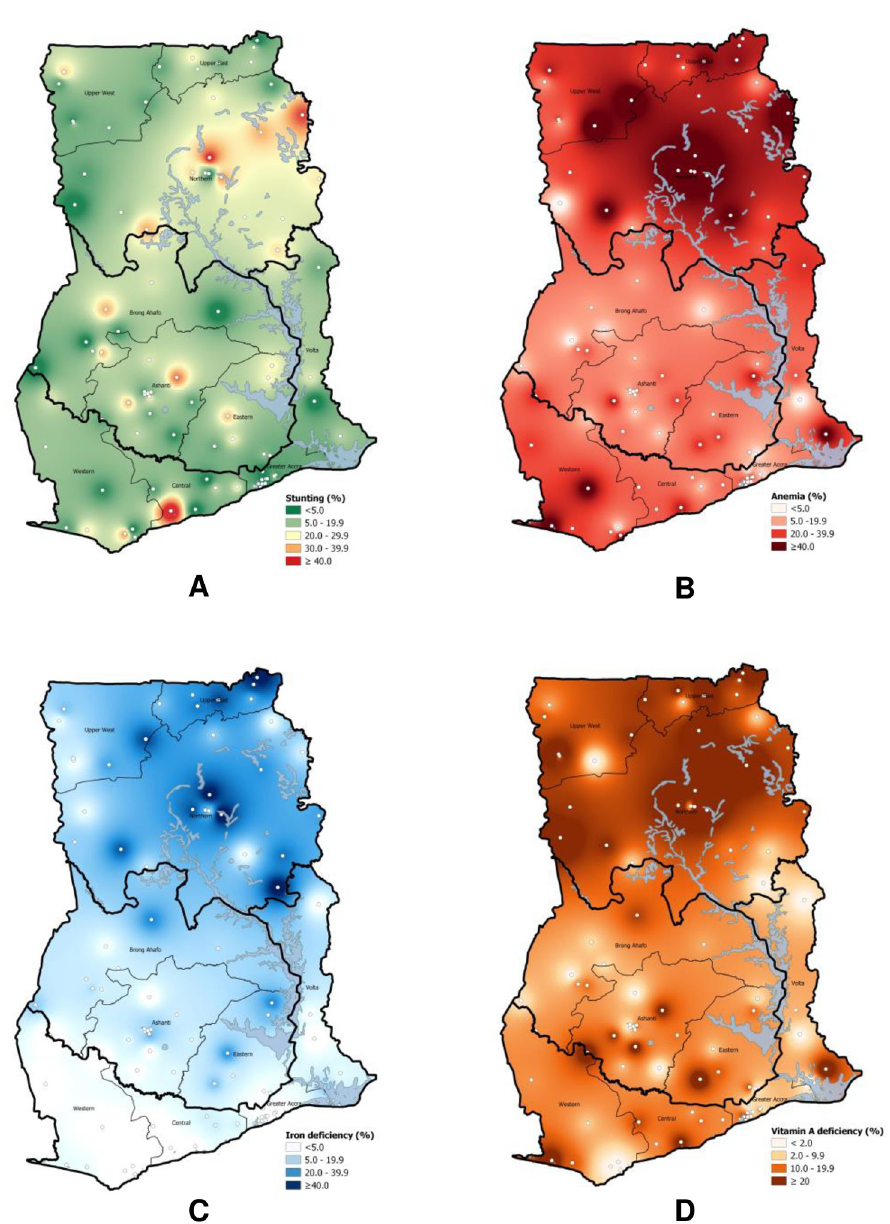
Fig 1. Geospatial distribution of prevalence of stunting (A), anemia (B), iron deficiency (C) and vitamin A deficiency (D) among preschool-age children, Ghana. White dots represent the EAs.